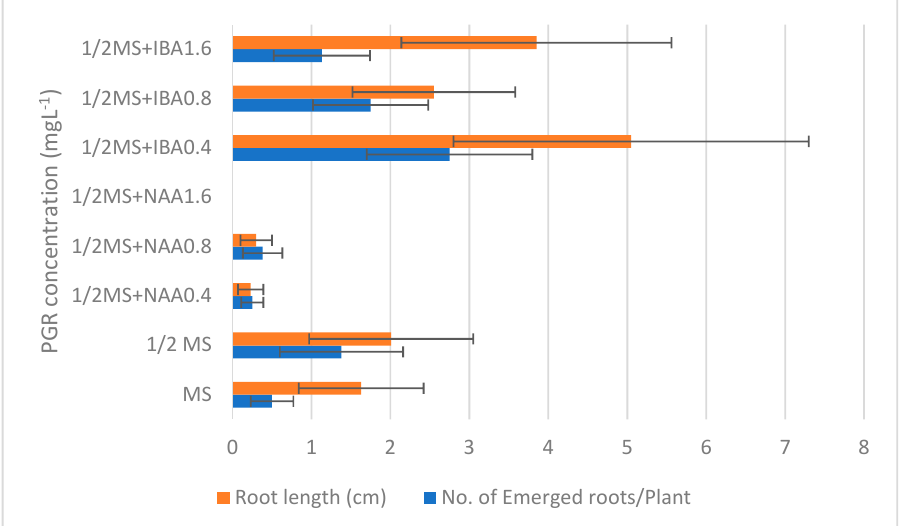
Figure 2. In vitro rooting of L. schweinfurthii shoots on MS medium fortified with different auxins. Pairwise comparison showed no significant differences between treatments at p ≤ 0.05 using the Holm–Sidak method. Eight replicates were used in each treatment. PGR, plant growth regulators; MS, full-strength MS salts; 1/2MS, half MS salts; IBA, indole-3-butyric acid; NAA, naphthalene acetic acid.